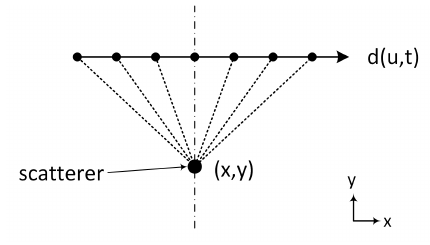
Figure 13. Monostatic linear SAR data